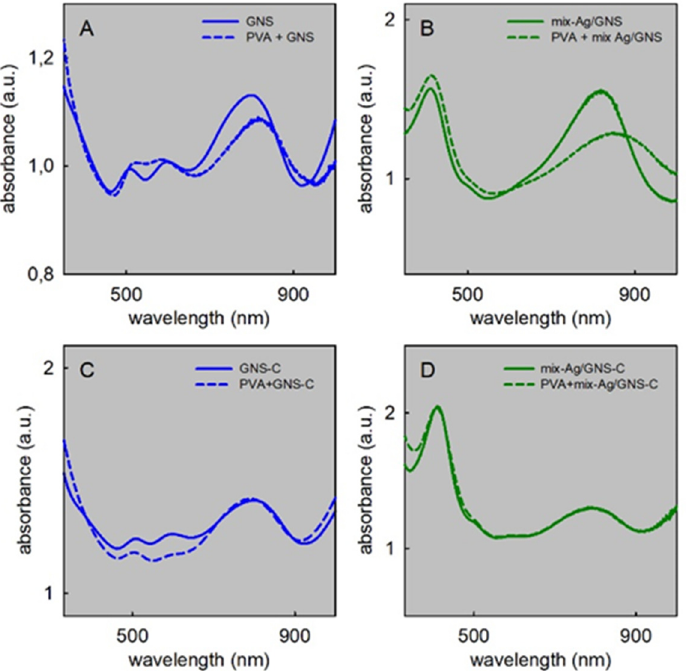
Figure 2. Absorption spectra of nanoparticles colloidal solutions before (solid lines) and after (dashed lines) addition of PVA: ( A ) GNS, ( B ) 1:2 AgNP:GNS mixture, ( C ) GNS-C and ( D ) 1:2 AgNP:GNS-C mixture.